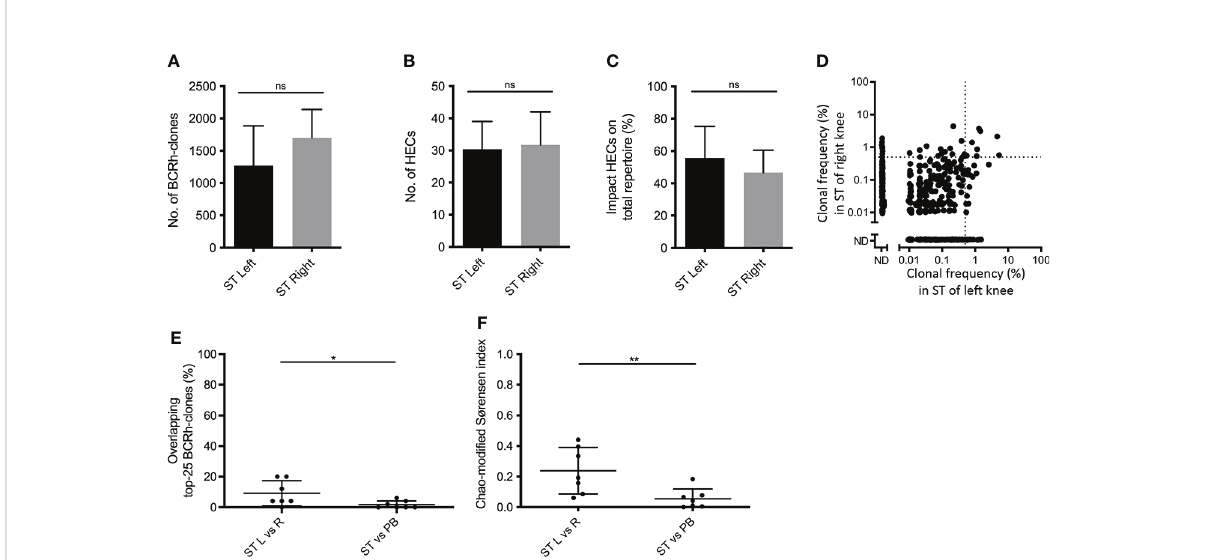
FIGURE 2 Comparing B-cell receptor repertoires in two contralateral in fl amed joints. Bar charts of (A) the number of BCR-clones, (B) number of highly expanded BCR-clones (HECs) and (C) impact of HECs on total repertoire per joint (bars show mean and SD; ns=not signi fi cant using a one- tailed Mann-Whitney test). (D) Representative example of overlap-plots from one patient when comparing the ST of the left (L) joint to right (R) joint, showing substantial overlap; for explanation see legend Figure 1D (E) Scatterplot of the impact of the top-25 overlapping BCR-clones and (F) the Chao-modi fi ed Sørensen indices of the total BCR-clonal repertoire when comparing different compartments (n=7; lines at mean and SD; * p<0.05, ** p<0.01 using a paired t